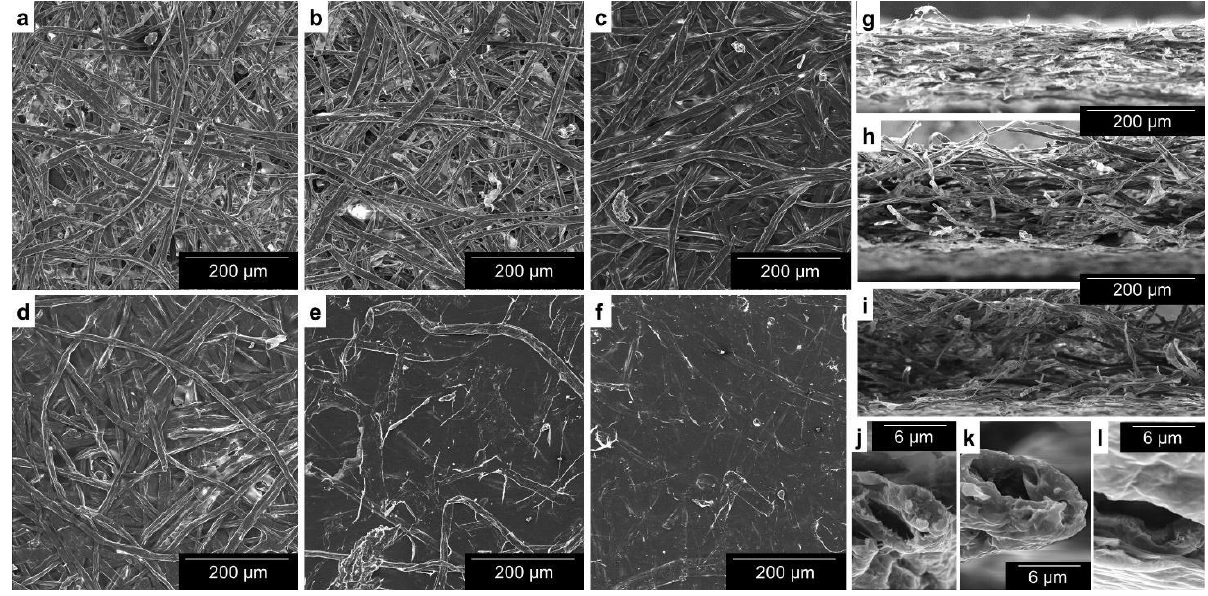
Figure 4. Visualization of the effect of surface treatments. SEM images of: ( a ) the surface of paper, at a magnification of 150×; ( b ) the surface of paper with 3 wt.% CMNFs (in-bulk) for comparison purposes; ( c ) the surface of paper without CMNFs in bulk, but bar-coated with three layers of CNFs; ( d – f ) the surface of paper sheets without CMNFs in bulk but coated by electrospray deposition of CNFs during 20, 40 and 60 min, respectively, at a magnification of 150×; ( g – i ) cross-sectional views of ( a , c , d ) sheets, respectively, at a magnification of 150×; ( j – l ) cross-sectional views of fibers corresponding to control paper, bar coating and electrospray deposition, respectively, at a magnification of 9000×.